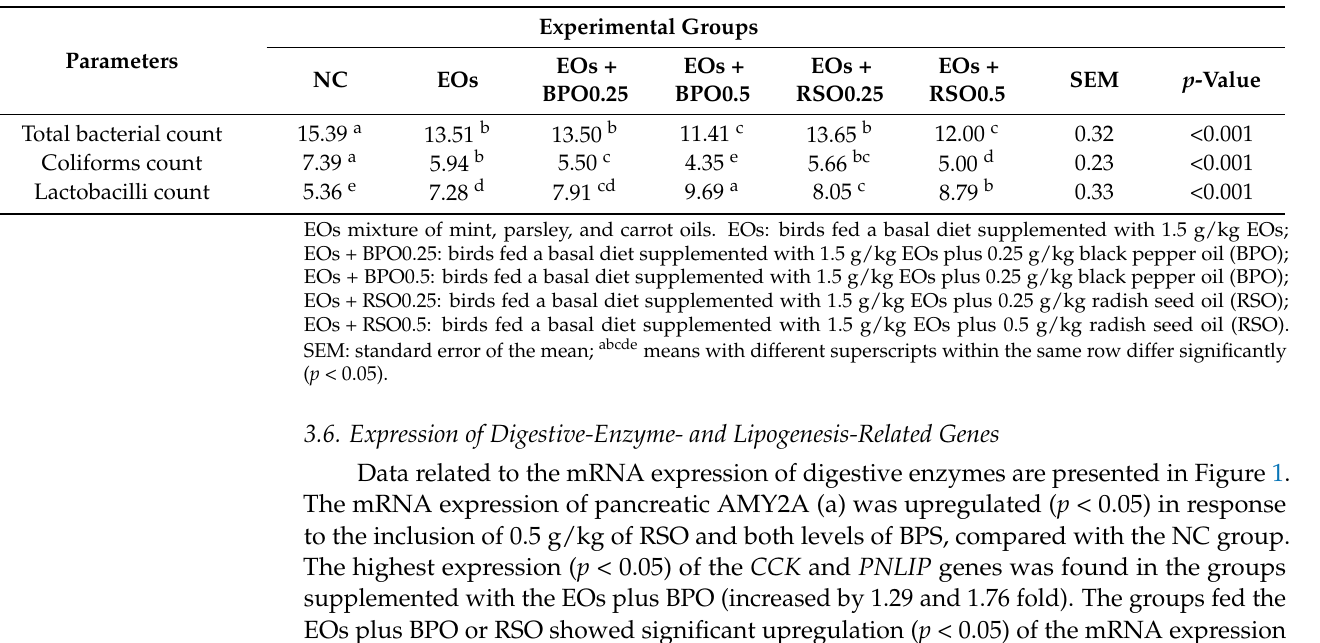
Table 7. Effect of EOs with black pepper oil or radish seeds oil on cecal bacterial count in broiler chickens (Log